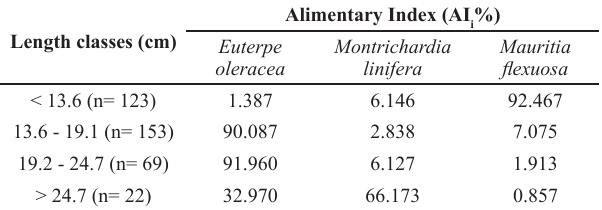
%) of the main plant species i